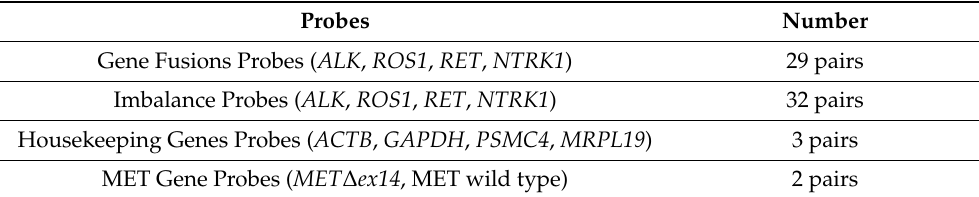
Table 1. Description of the nCounter codeset used in the